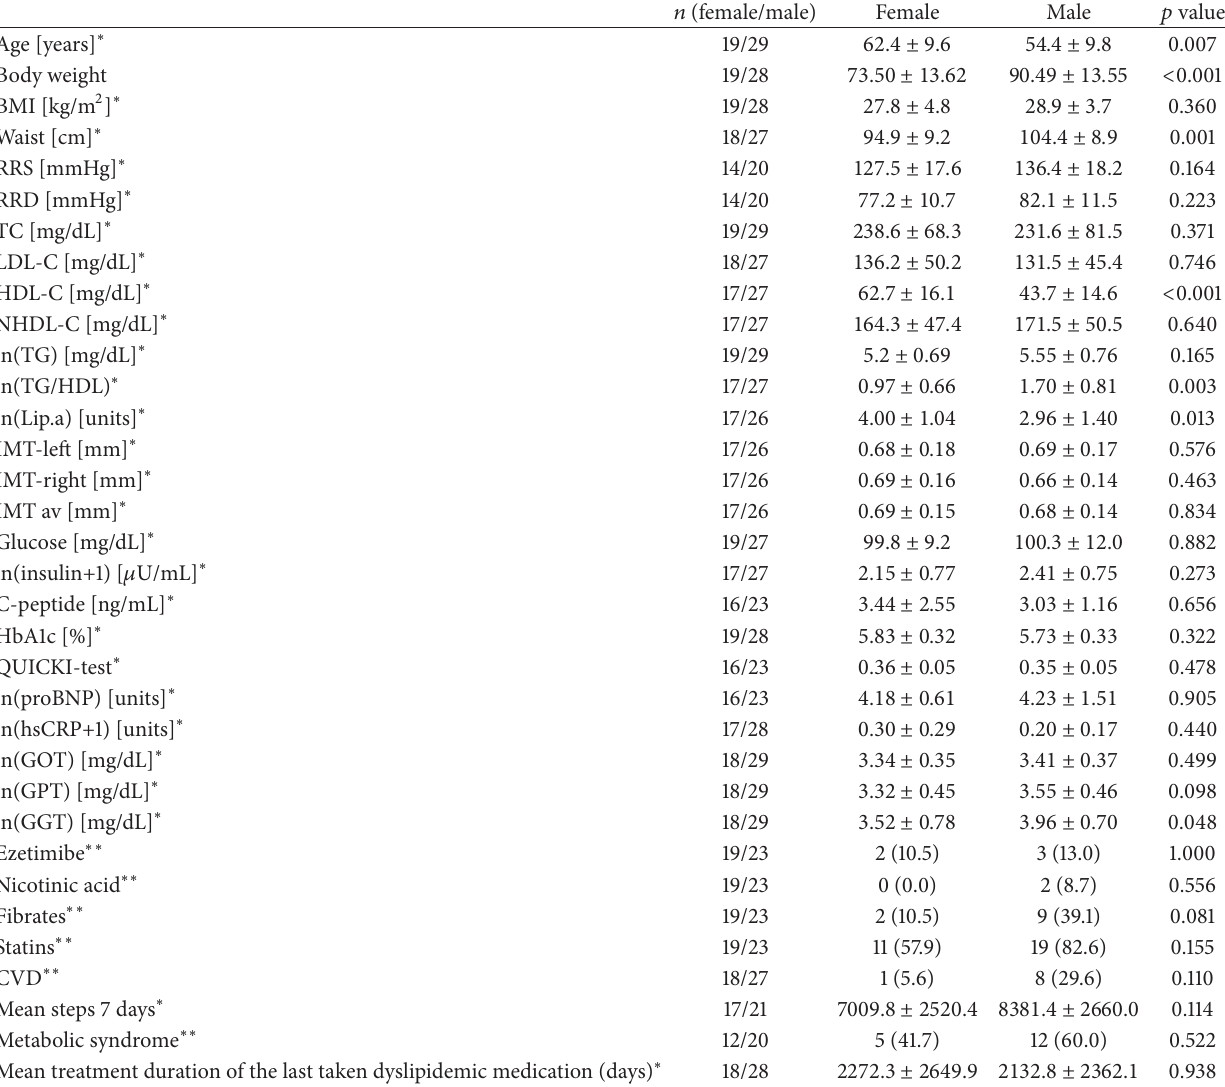
Table 2: Characteristics of the study sample with prediabetes, divided by